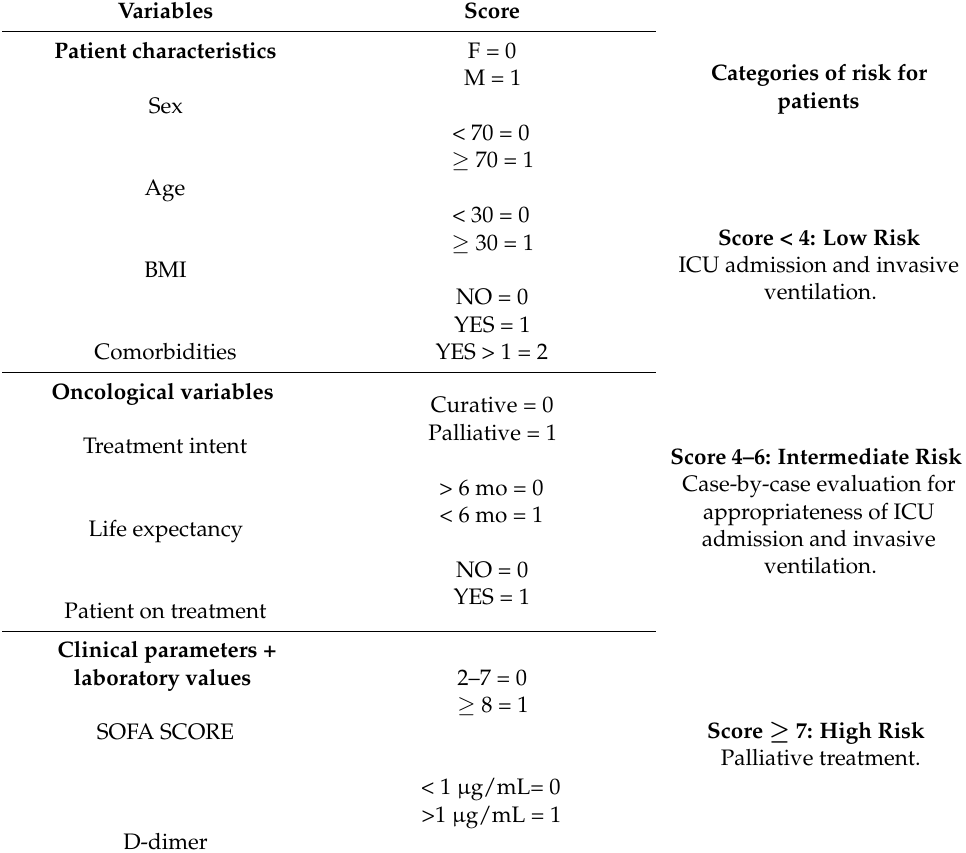
Table 2. The Milano Policlinico ONCOVID-ICU